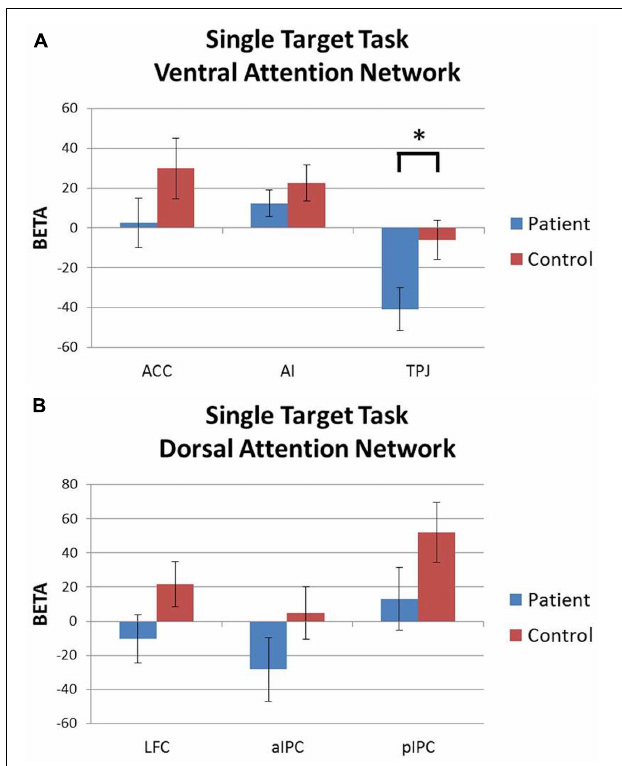
FIGURE 4 | Single target task ROI analysis by network (contrast: single target task > baseline). (A) Ventral attention network: patients showed significantly greater deactivation of TPJ than controls. (B) Dorsal attention network: no significant group differences. ∗ p <